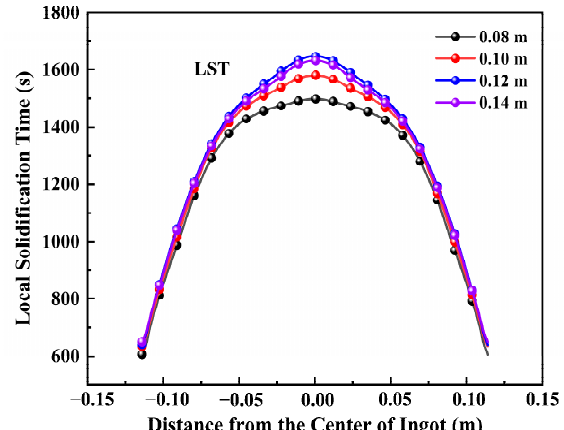
Figure 16 plots the specific change of PDAS and SDAS at half height of ESR ingot. The same evolution rule of PDAS and SDAS can be found. There is almost no difference in PDAS and SDAS for the structure size in the zone out of the midridus of the ingot for varying slag thicknesses. PDAS and SDAS in the center increase firstly and then has a slight decreasing tendency, which agrees with change of LST as shown in Figure 15. The slag thickness changes the heat in the metal pool, subsequently the metal pool depth changes LST. Different LST allows more or less time for nucleation and growth of grains. Eventually, the change result is revealed by dendrite arm spacing.